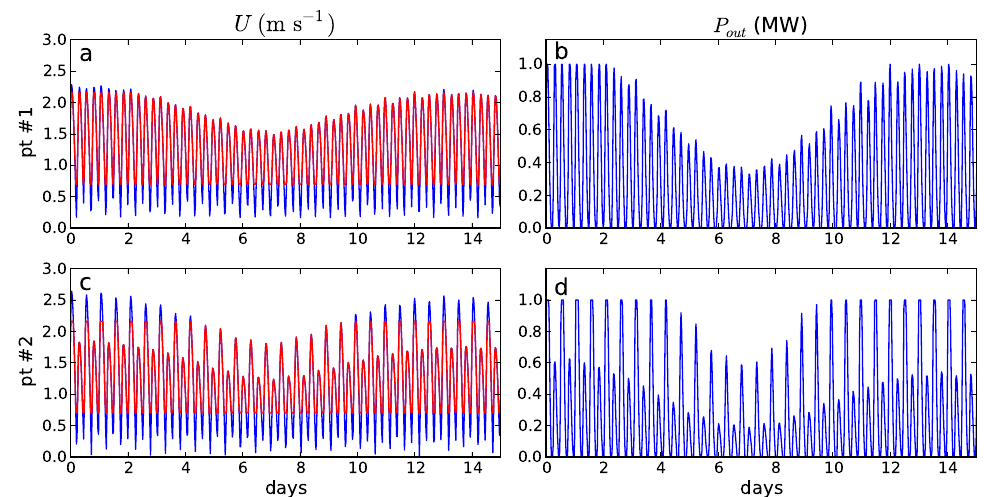
Figure 7. Predicted tidal current speeds at 10 m above the seabed in spring-neap conditions ( a , c ) and associated generated practical power from a 1-MW turbine ( b , d ) at Points #1 and #2 (Figure 6b). The red line accounts for the effective tidal velocity that generates